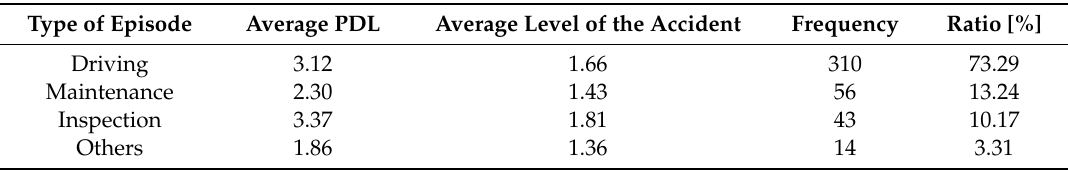
Table 3. Episode distributions relying on the “type of